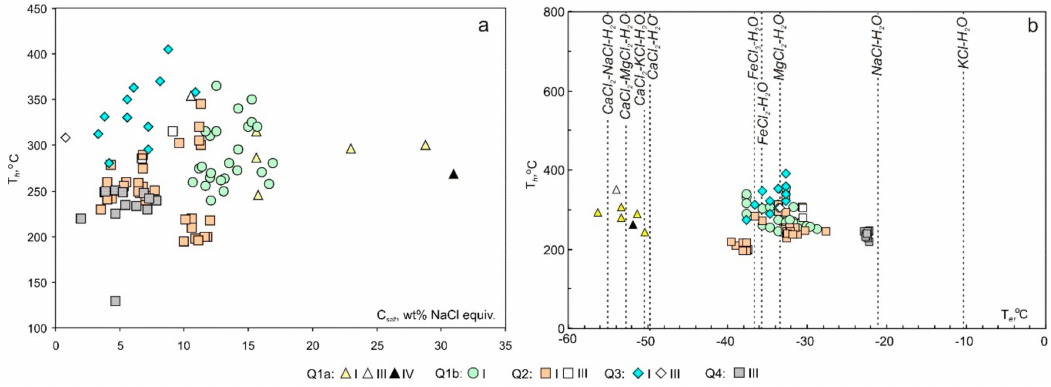
Figure 6. Homogenisation temperature ( T h ) vs. salinity ( C salt ) ( a ) and homogenisation ( T h ) vs. eutectic temperatures ( T eut ) ( b ) plots for FIs in the quartz of the Svetlinsk